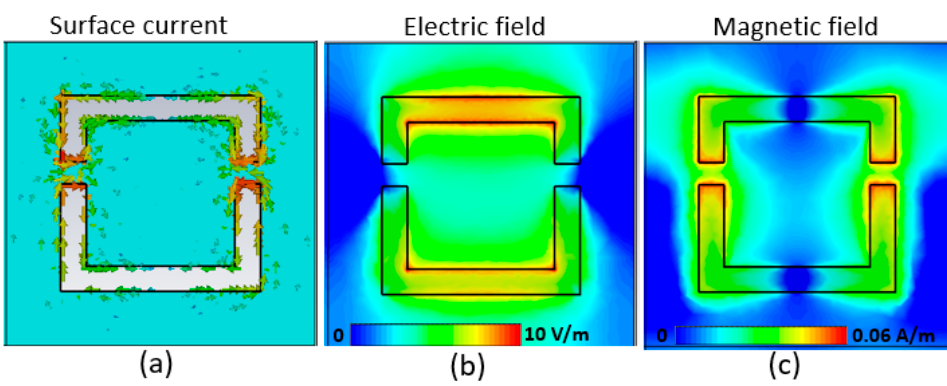
Figure 4. ( a ) Simulated surface current at the resonance frequency of 0.435 THz when the E -field is oriented along the y-direction. ( b ) The electric field and ( c ) the magnetic field spatial distributions without analyte for an excitation field amplitude of 1 V/m